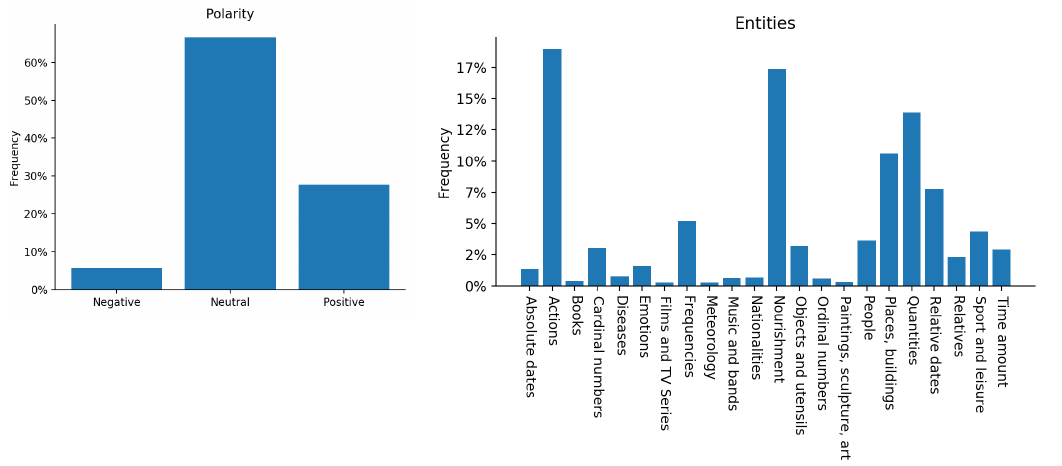
Figure 4. ( Left ) Distribution of the polarity in each subsentence. ( Right ) Distribution of the entities.